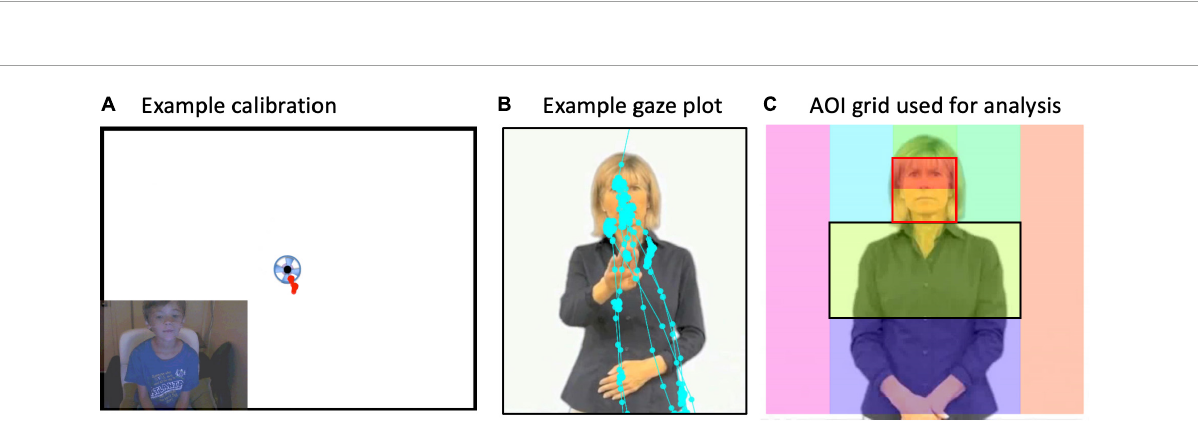
FIGURE2 (A) Example calibration from a child. If the gaze “hit” the spinning circle at each beginning, middle, and at the end of the experiment, then data were included in analyses. (B) Example “raw” gaze plot showing fixation points from one trial and one participant. (C) The signer was superimposed with an Areas of Interest (AOI) grid. Gaze points in each box were summed to equal the total time spent gazing at each AOI box. Then, for main analyses, percent looking in each AOI box was computed as total looking time spent in the AOI divided by the total amount of time spent looking at the whole image (i.e., all boxes). Gaze data primarily hit the midline column of AOIs and rarely off the signer’s body. Main analyses were conducted on face preference index (FPI) values. FPIs were calculated for each participant as the Face AOI (outlined in red ) divided by the Face and “Torso” AOIs (outlined in black